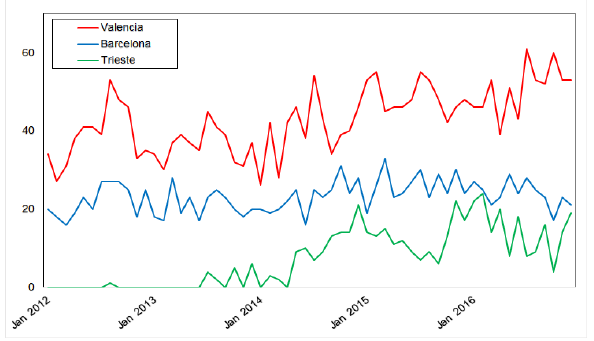
Figure 7 Variation of counted AIS’ positions per bin in Valencia, Barcelona and Trieste port locations (2012-2016).